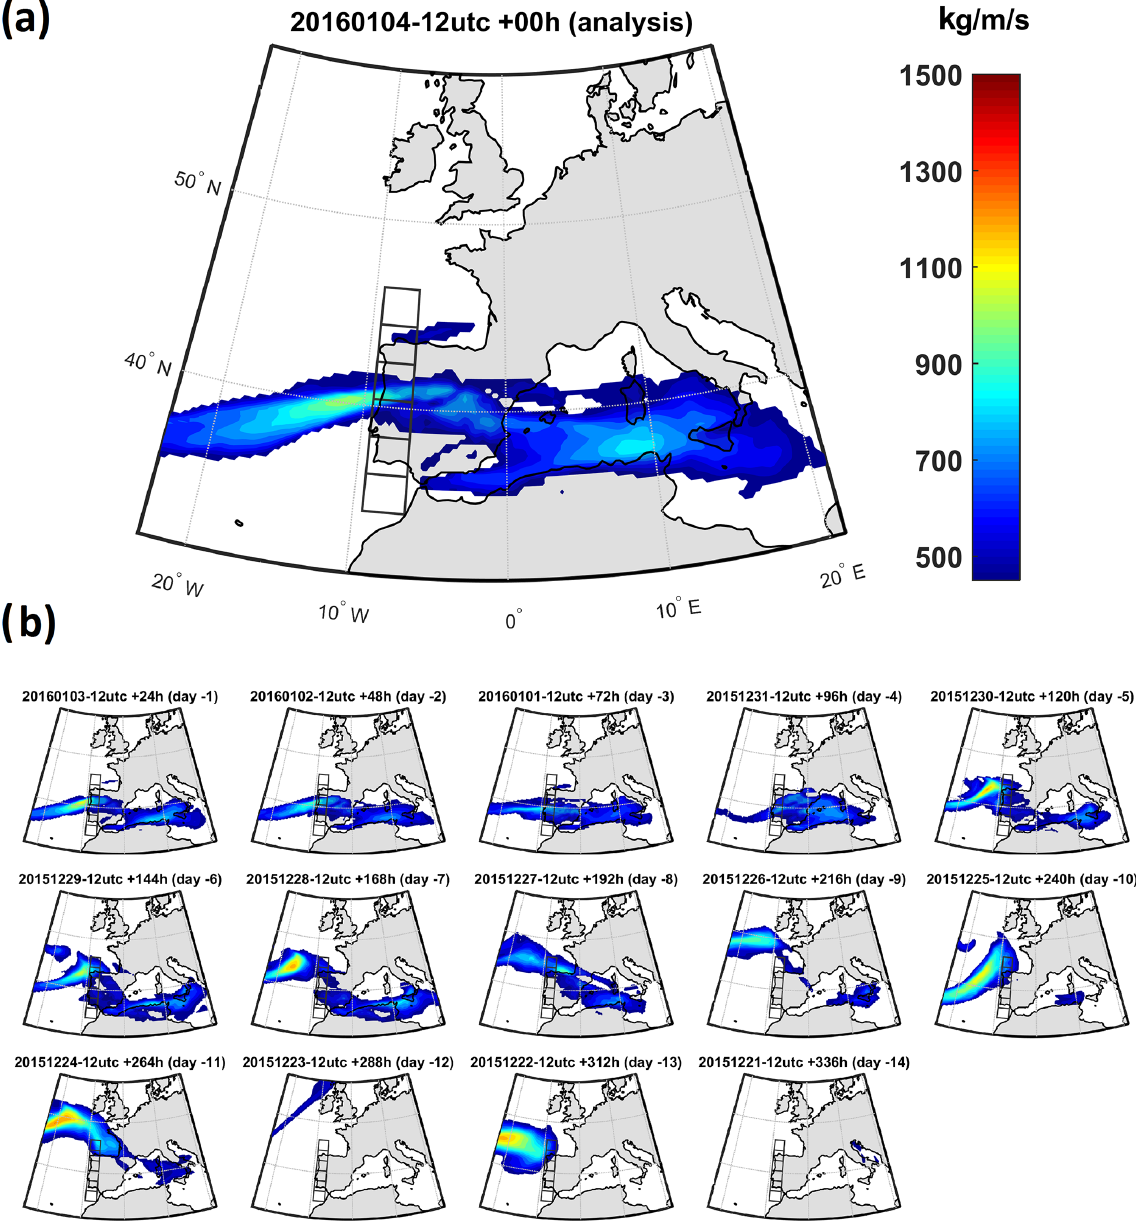
Figure 3. Shown is an example of the evolution of operational forecasting of the IVT in an event affecting western Iberia: (a) analysis of the IVT fields on 4 January 2016 at 12:00UTC; (b) control forecasts for that date issued with different lead times, from 1 to